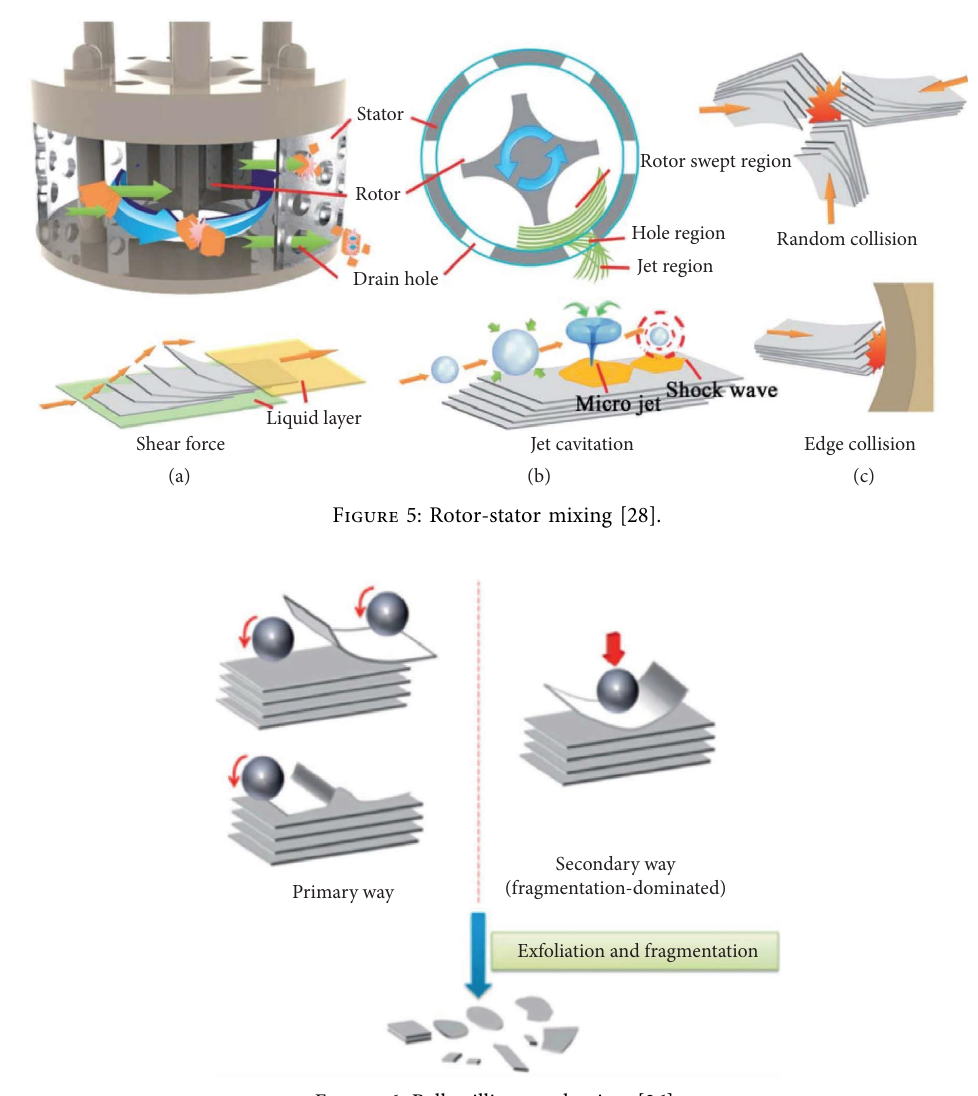
Figure 6: Ball milling mechanism